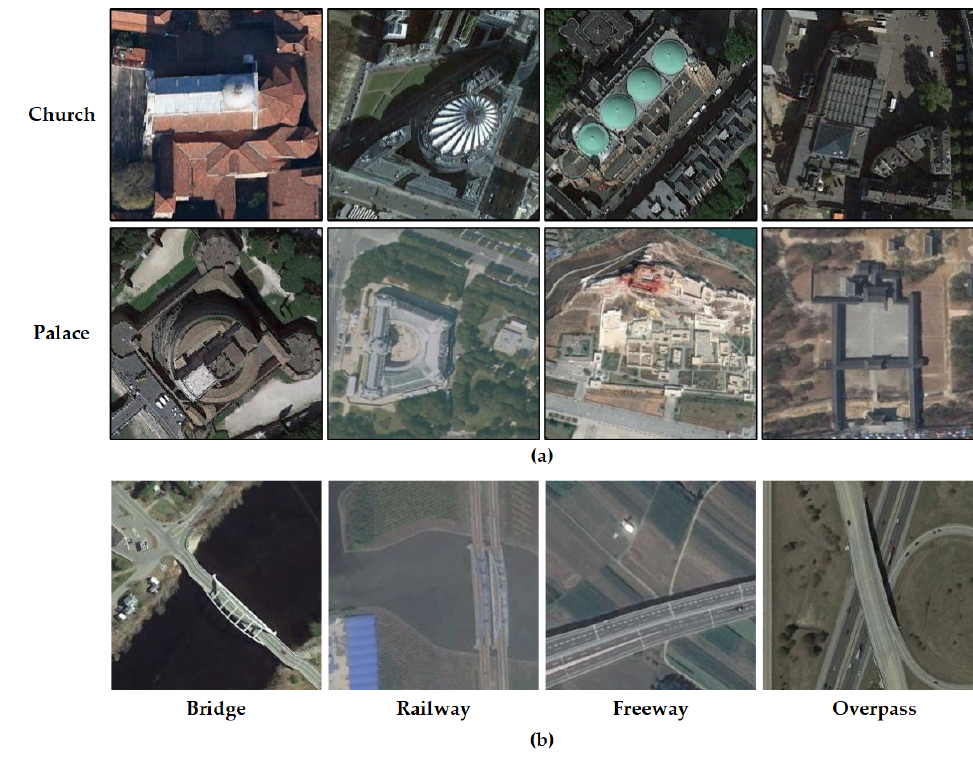
Figure 1. Instance samples in NWPU-RESISC45 dataset [24]. ( a ) presents different examples of the same category. ( b ) presents instance examples of different